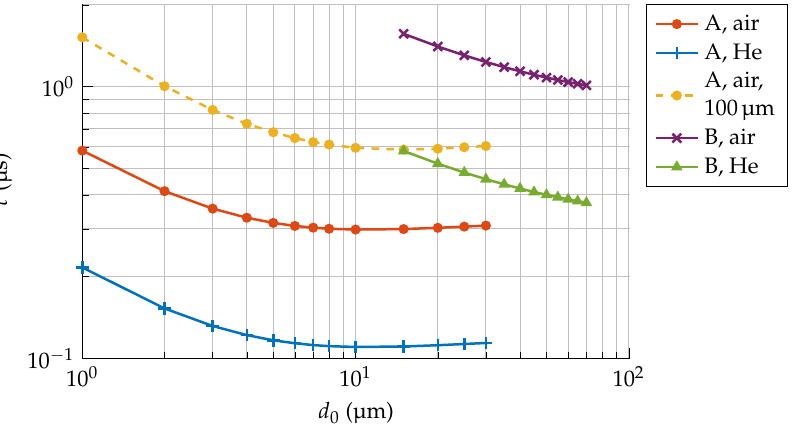
Figure 4. Molflow+ simulation results for the diffusion time τ as a function of plate separation d 0 for air and helium particles at 300K, escaping from regions A and B as indicated in Figure 1c. The dashed curve corresponds to particles escaping from region A, but with a 100µm thick silicon